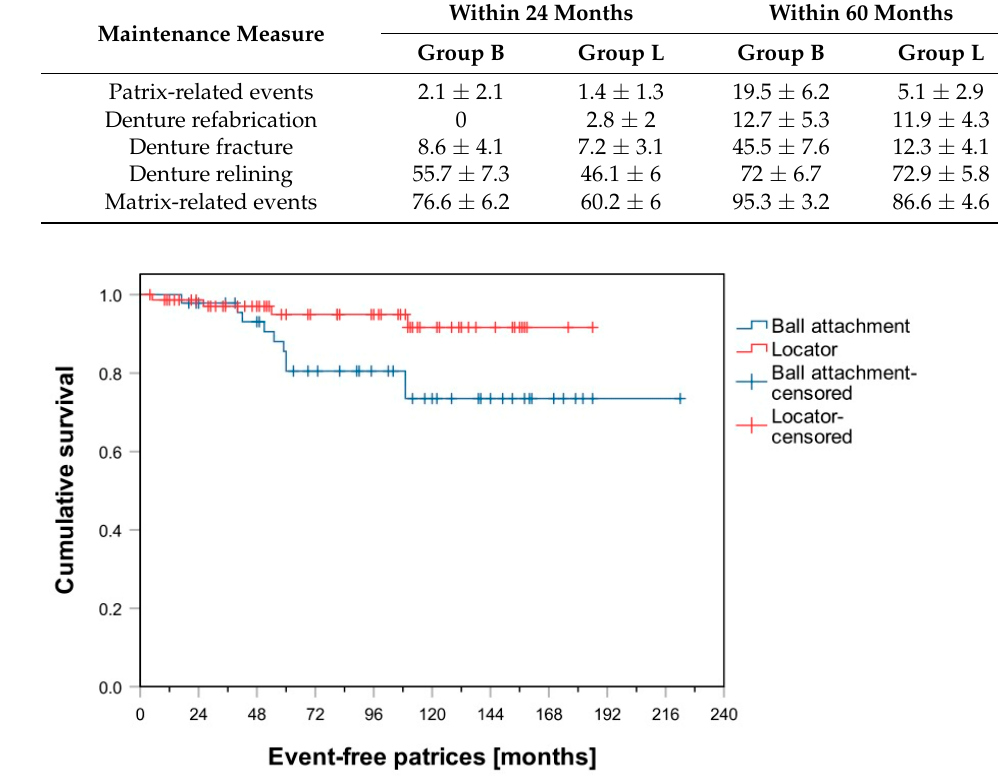
Figure 1. Kaplan–Meier survival curves for ball and Locator attachments regarding patrix-related events.